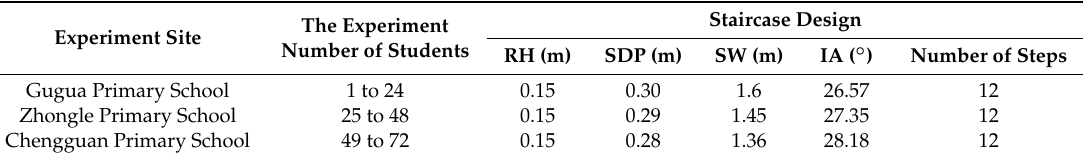
Table 2. Detailed data of experiment